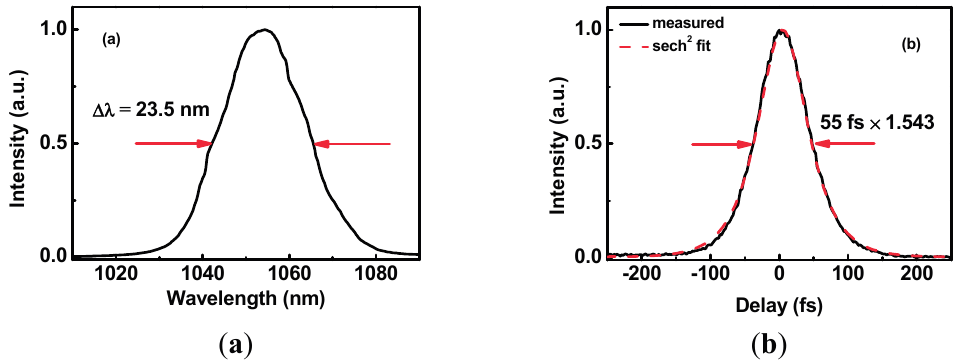
Figure 6. ( a ) Spectrum of the femtosecond pulses centered at 1054 nm; ( b ) Autocorrelation trace showing the pulse duration was 55 fs assuming a sech 2 pulse shape. Black curve, measured data; red dashed line, sech 2 fitted